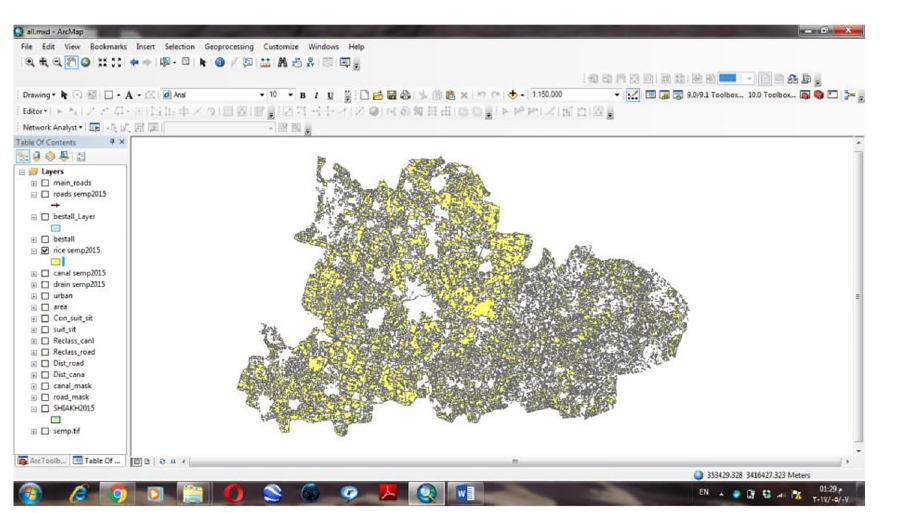
Figure 2. Rice area